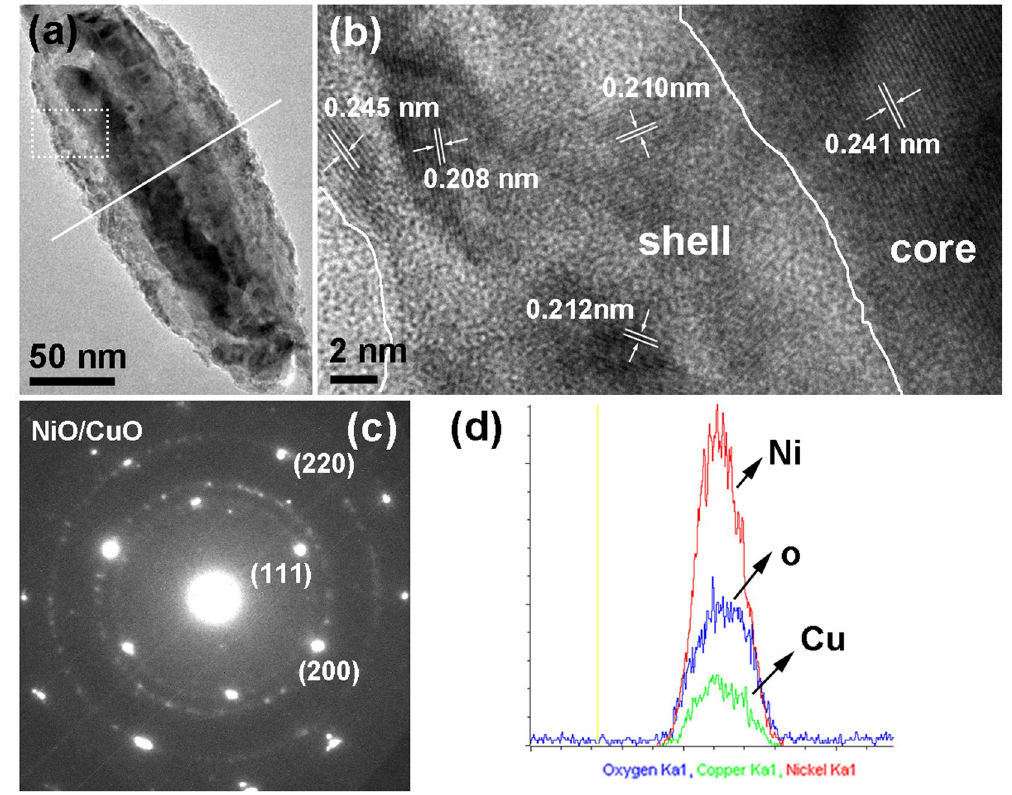
Figure 4. Characterization results of the core-shell structure. ( a ) The high magnification TEM image of the thick segment; ( b ) the HR-TEM image of the area labeled in ( a ); ( c ) the corresponding SAED patterns of the thick segment; ( d ) the EDS line scanning image of the thick segment along the radial orientation as the white line shown in ( a